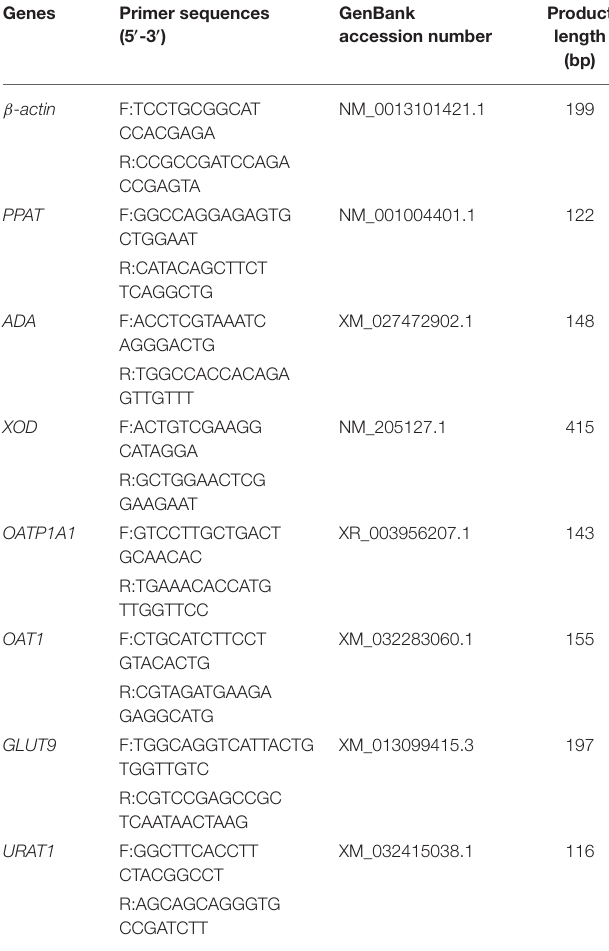
TABLE 2 | Gene primer sequence